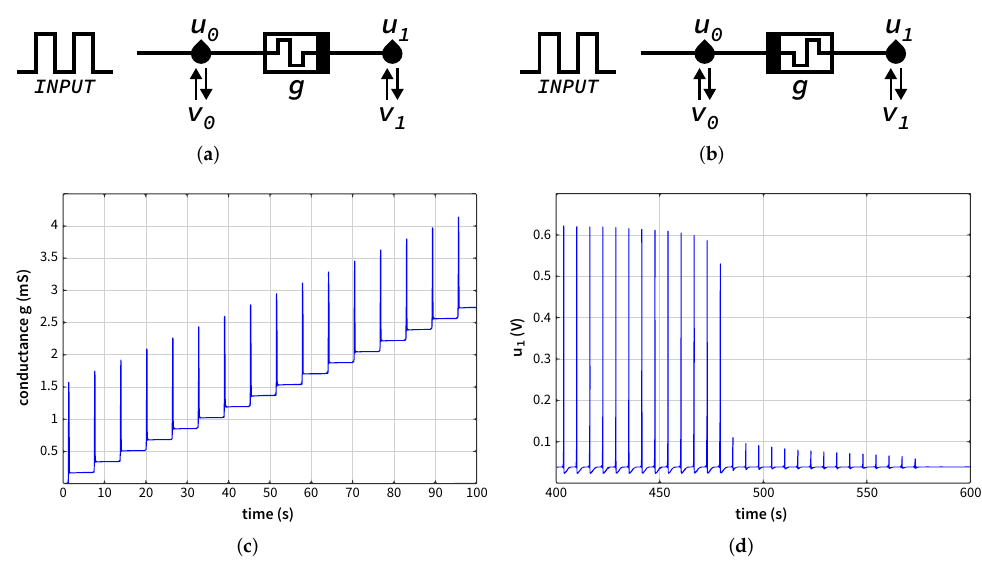
Figure 4. ( a , b ) Two Oregonator elements connected via a memristor with different polarities. ( c ) The increase of the conductance with time for the circuit in ( a ). ( d ) Development of u 1 in ( b ), for u 1 originally activated by u 0 , and given that the conductance decreases with time, u 1 reaches the inactive